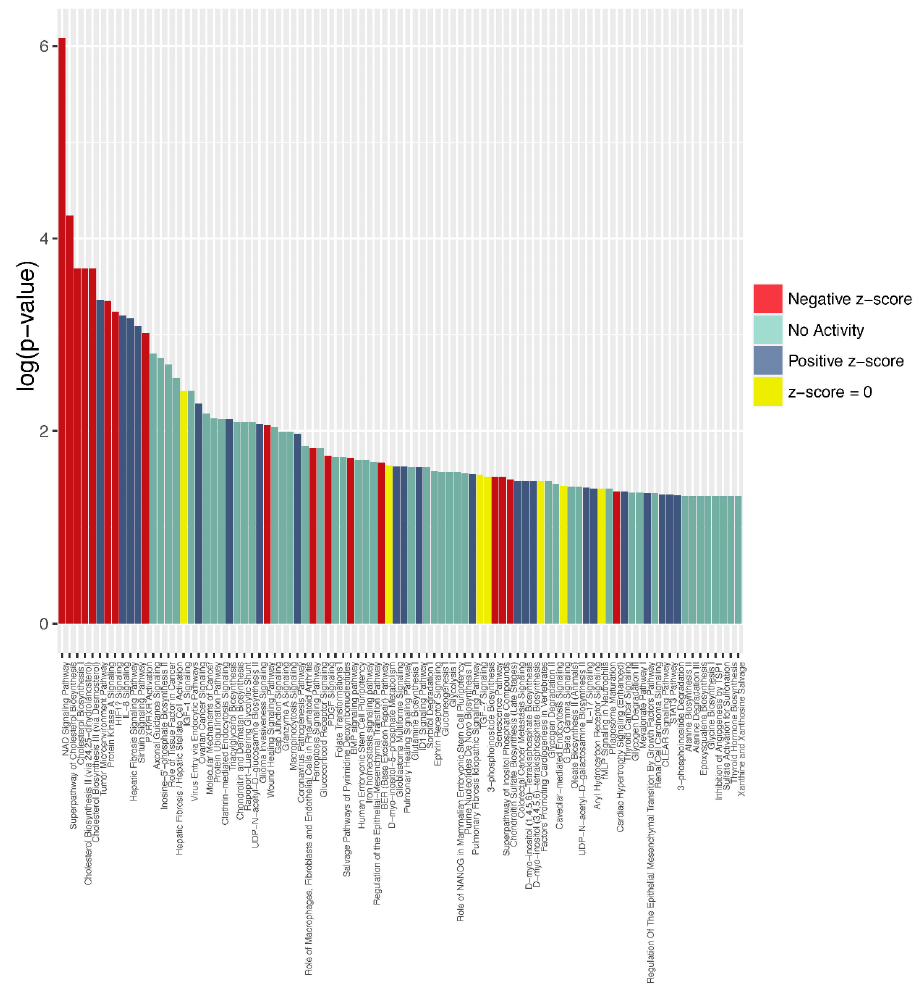
Figure 6. Ingenuity Pathway Analysis identified canonical pathways for human expression amongst − log( p -value) and z-score classes. The bar plot describes all the canonical pathways for the z-score positive, negative, zero, and no activity pattern.